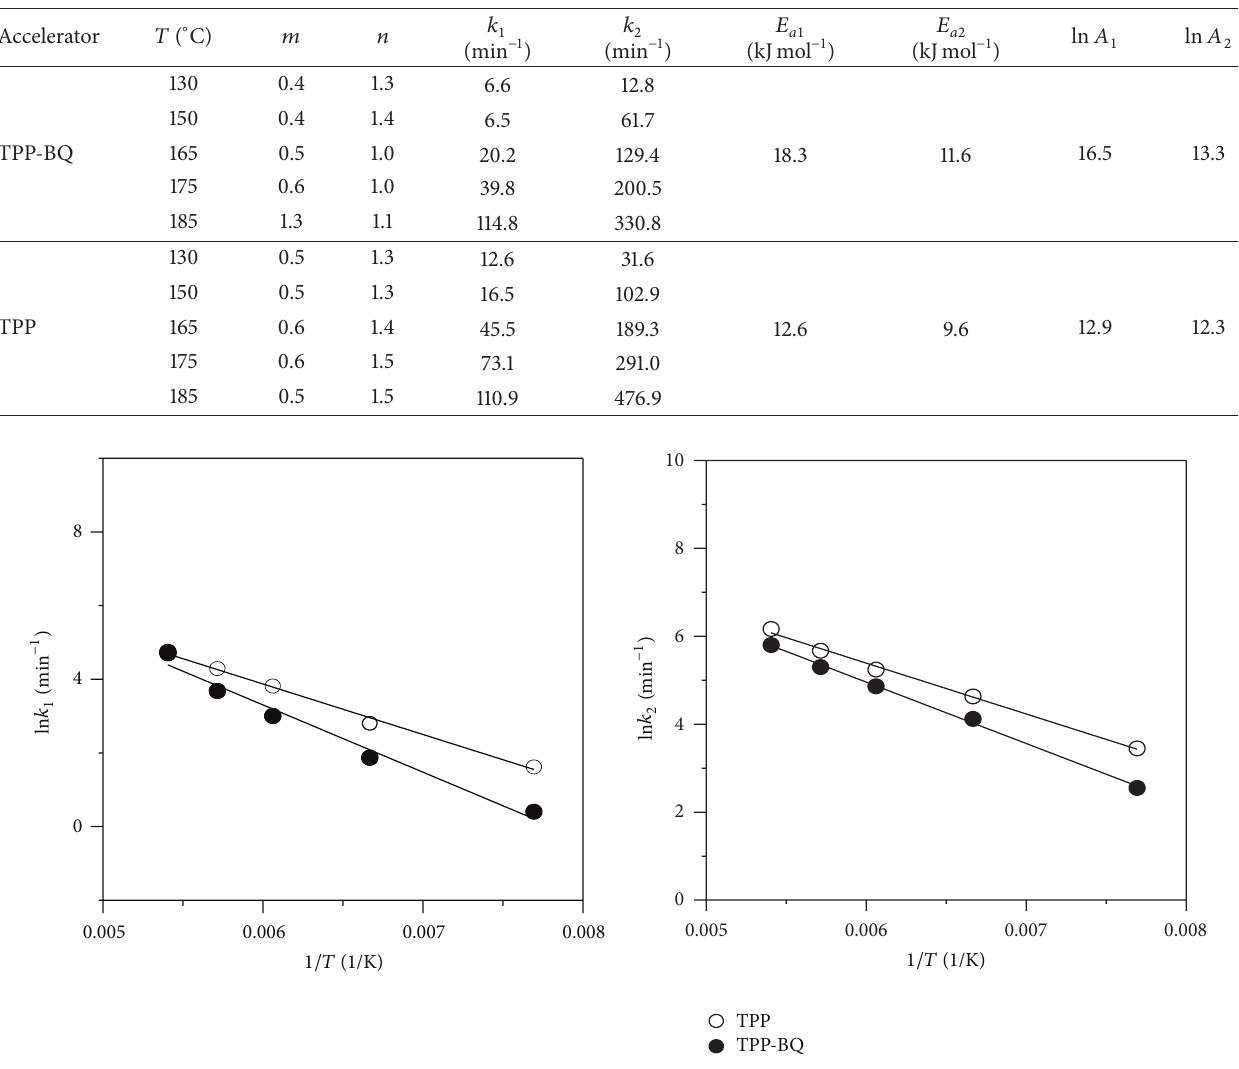
Table 3: Kinetic parameters for epoxy molding compounds catalyst by TPP and TPP-BQ. Accelerator